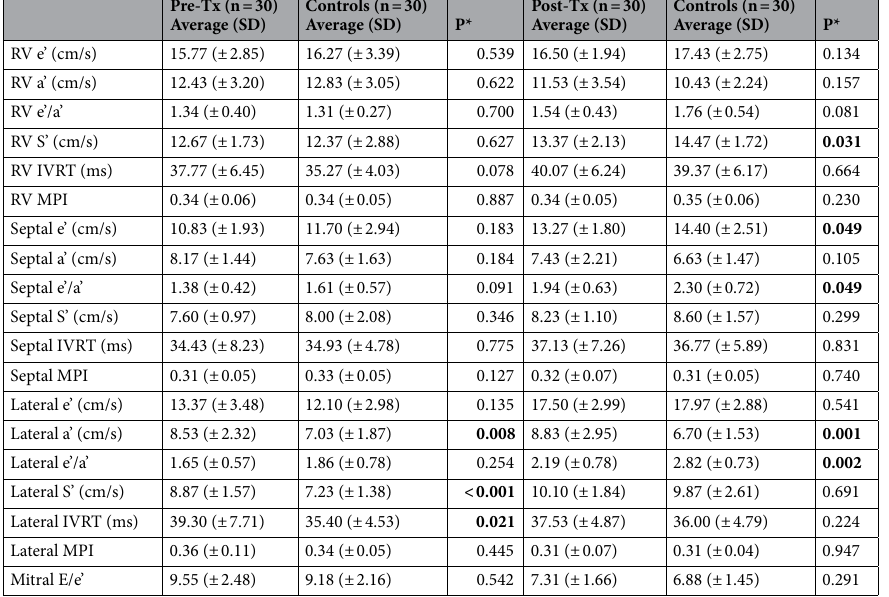
Table 4. Tissue Doppler imaging. Statistical significance p < 0.05. IVRT, isovolumic relaxation time; MPI, Myocardial Performance Index; *Students t-test.